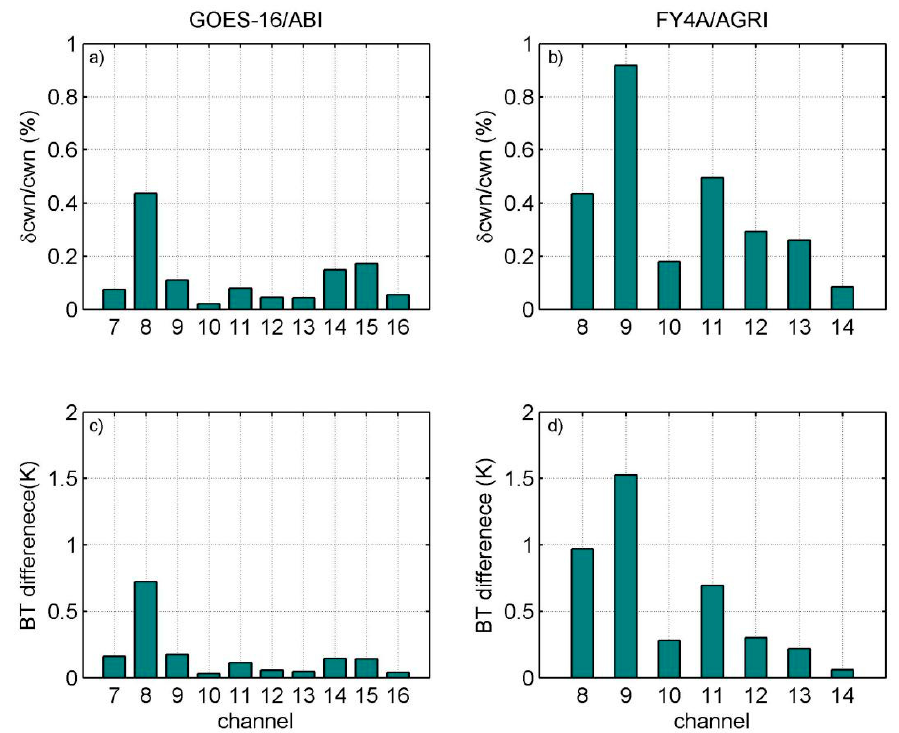
Figure 2. Mean ( a,c ) central wavenumber differences and ( b,d ) central wavenumber caused BT differences (BTDs) from the six standard atmospheric profiles for ABI and AGRI IR bands, respectively.